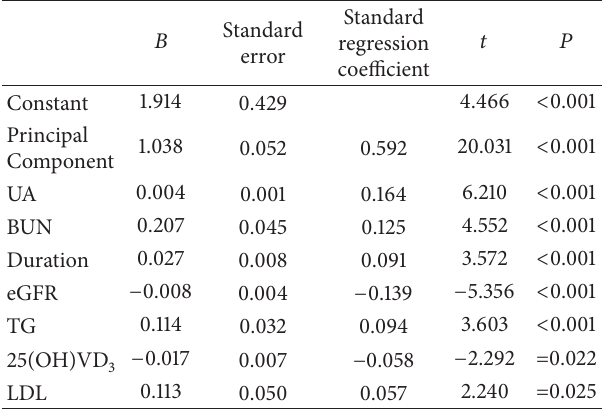
Table 2: Relationship between Ln(ACR) and various factors. Variable